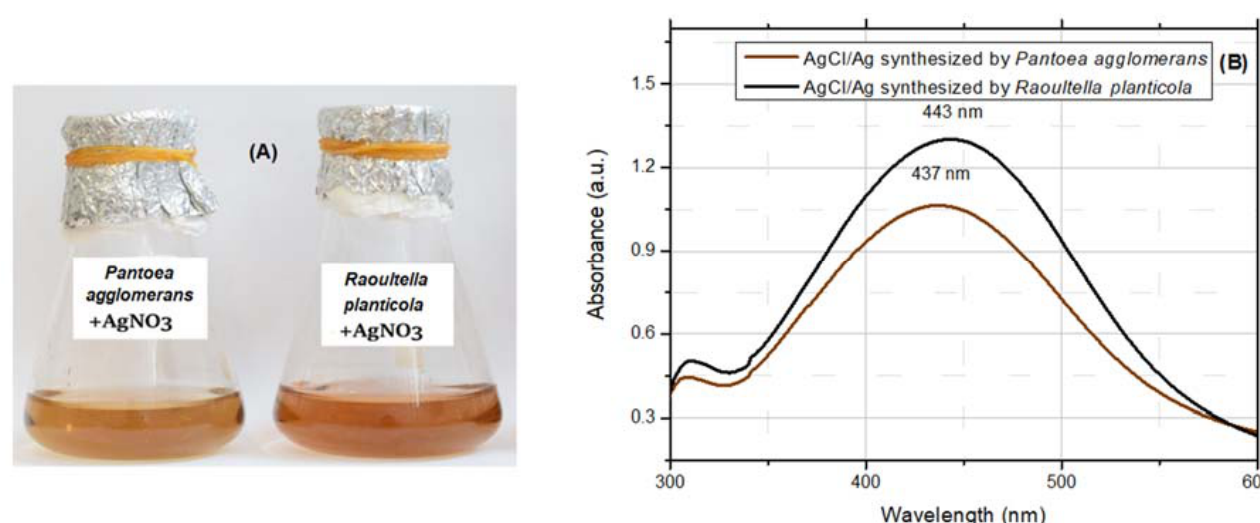
Figure 1. ( A ) Colloids with Ag/AgCl nanoparticles (NPs); ( B ) UV-visible spectra of colloids with Ag/AgCl nanoparticles, biosynthesized by Raoultella planticola and Pantoea agglomerans .